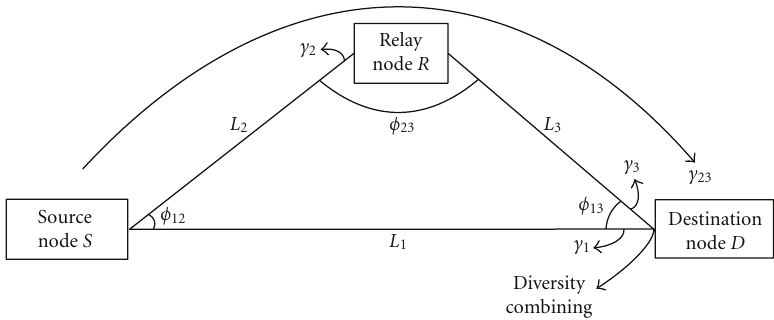
Figure 1: Geometrical configuration of the cooperative diversity